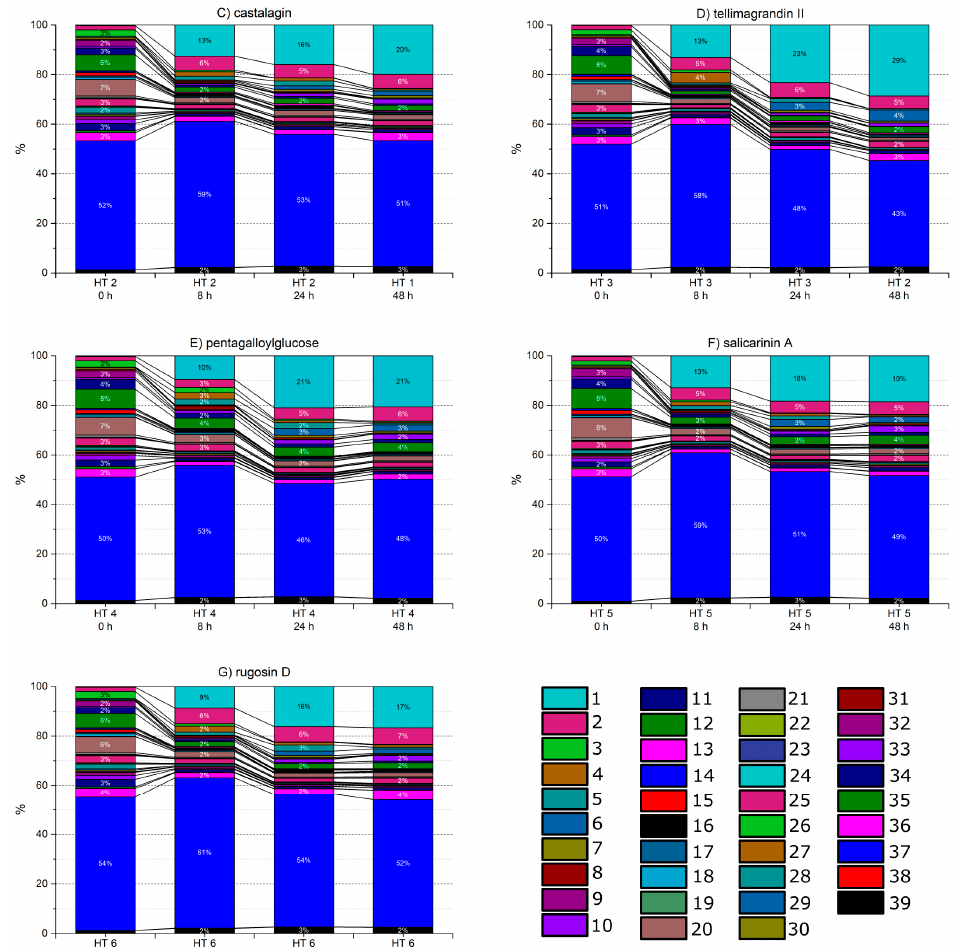
Figure A4. Bacterial DNA sequencing results of the fecal batch culture sample set treated with different hydrolyzable tannins (HTs). ( A ) Negative control, ( B ) positive control, ( C ) HT 2 = castalagin, ( D ) HT 3 = tellimagrandin II, ( E ) HT 4 = pentagalloylglucose, ( F ) HT 5 = salicarinin A, and ( G ) HT 6 = rugosin D treated samples. Labels annotated for sequences with more than 1% relative concentration. Legend titles (sequenced bacterial order, family, genus): (1) Enterobacteriales, Enterobacteriaceae , –; (2) Burkholderiales, Alcaligenaceae , Sutterella ; (3) RF32, –, –; (4) Erysipelotrichales, Erysipelotrichaceae , Catenibacterium ; (5) Erysipelotrichales, Erysipelotrichaceae , –; (6) Clostridiales, Veillonellaceae , Veillonella ; (7) Clostridiales, Veillonellaceae , Dialister ; (8) Clostridiales, Veillonellaceae , –; (9) Clostridiales, Ruminococcaceae , Ruminococcus ; (10) Clostridiales, Ruminococcaceae , Oscillospira ; (11) Clostridiales, Ruminococcaceae , Faecalibacterium ; (12) Clostridiales,